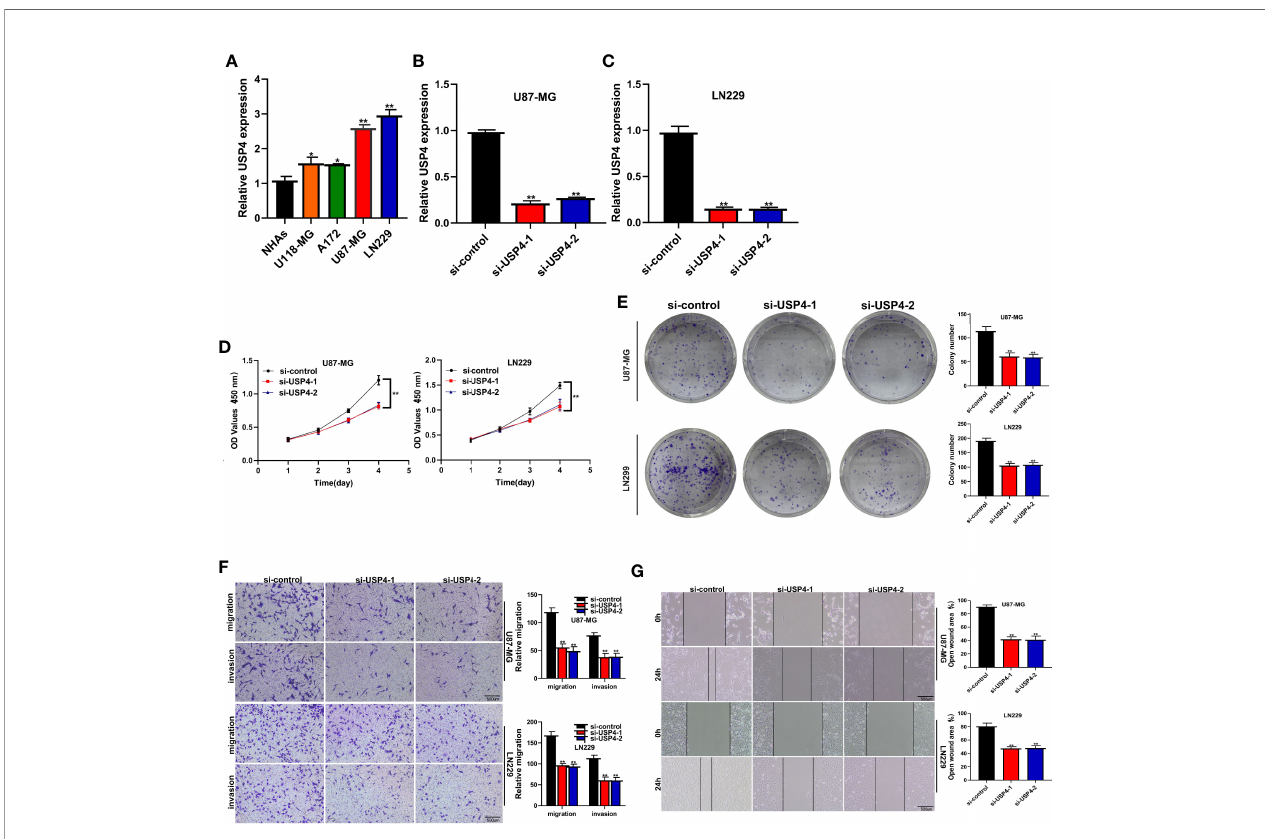
FIGURE 11 | In vitro experiment after USP4 knockdown. (A) PCR test. Compared with NHAs normal control, USP4 was up-regulated in U118-MG, A172, U87-MG and LN229 glioma cell lines, with U87-MG and LN229 having the highest expression levels (*P < 0.05, **P < 0.01). (B) Then U87-MG and LN229 cell lines were transfected with siRNAs. (C) Both two siRNAs signi fi cantly down-regulated USP4 expression in U87-MG and LN229 cell lines (**P < 0.01). (D) CCK-8 experiments. After USP4 knockdown, the activity of U87-MG cell line and LN229 cell line decreased signi fi cantly. (E) After USP4 knockdown, the cloning ability of U87-MG cell line and LN229 cell line decreased signi fi cantly. (F) Transwell assay. After USP4 knockdown, the migration and invasion abilities of U87-MG cell line and LN229 cell line were signi fi cantly decreased. (G) Scratch test. After USP4 knockdown, the migration ability of U87-MG cell line and LN229 cell line decreased signi fi